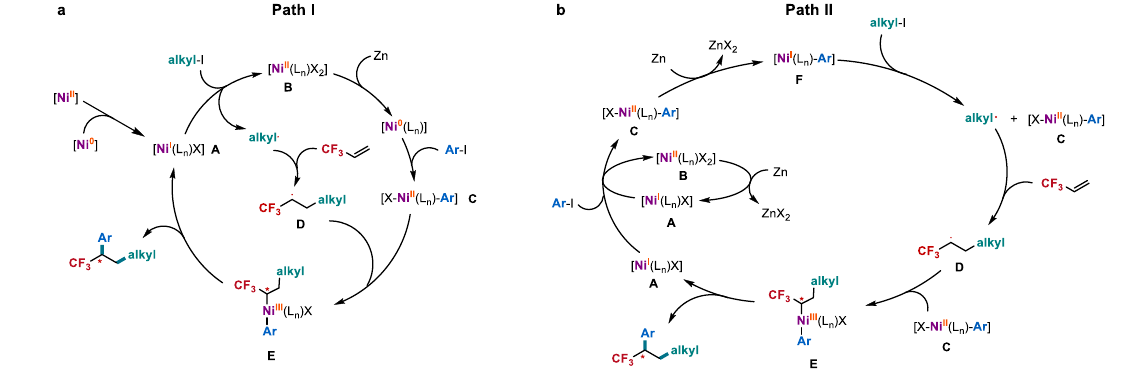
Fig. 5 | Proposed reaction mechanisms. a Possible mechanism I (path I). b Possible mechanism II (path